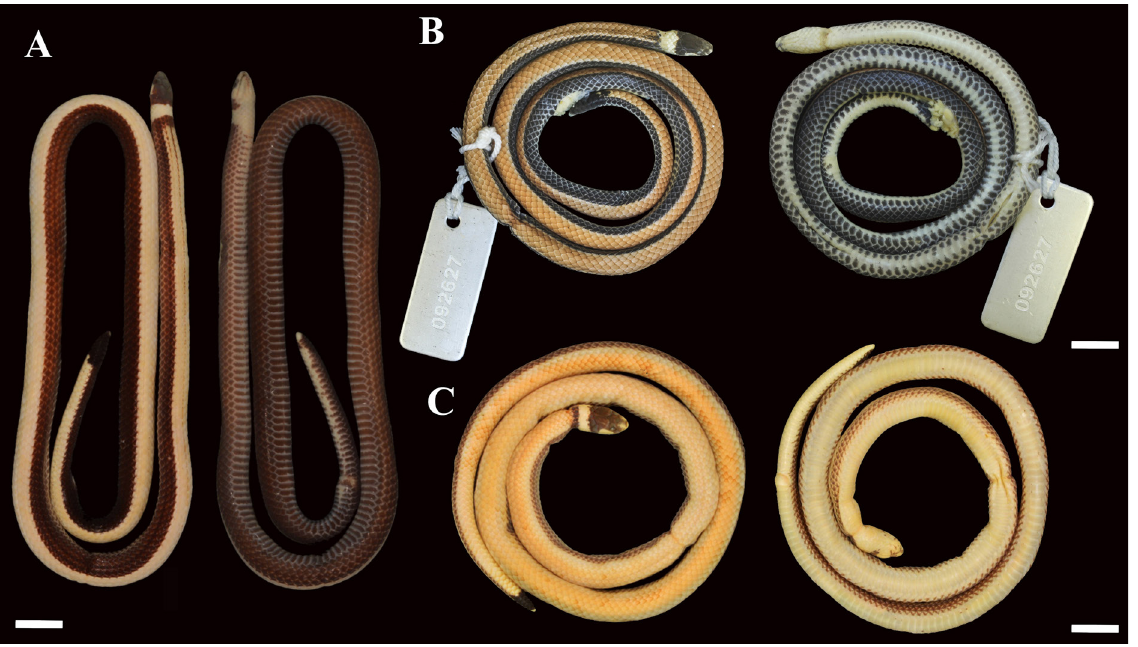
Fig. 1. Degrees of morphological variation in dorsal and ventral view, of Apostolepis Cope, 1862